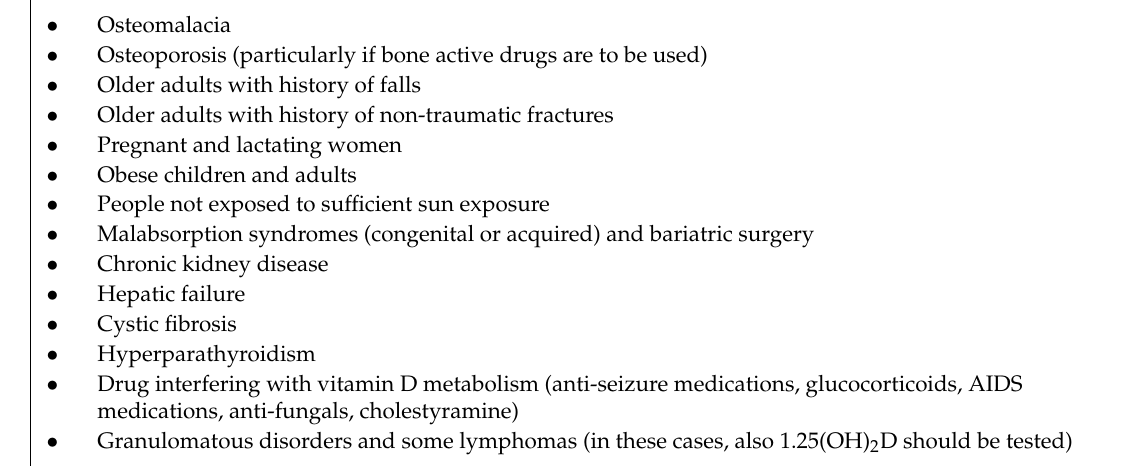
Table 1. Categories of patients that should be screened for vitamin D